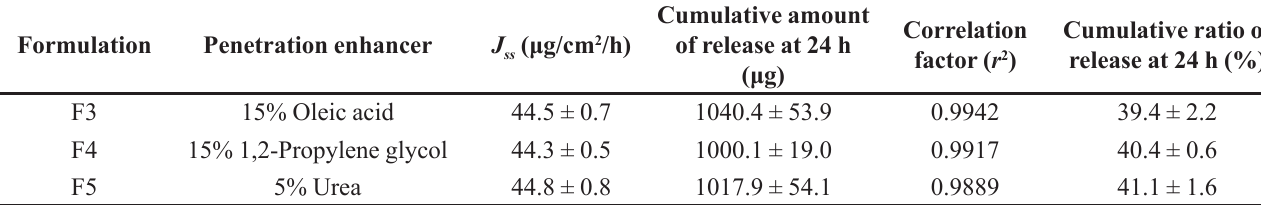
TABLE III - Permeation of ISDN in PVA reservoir with different penetration enhancers transporting through the M1